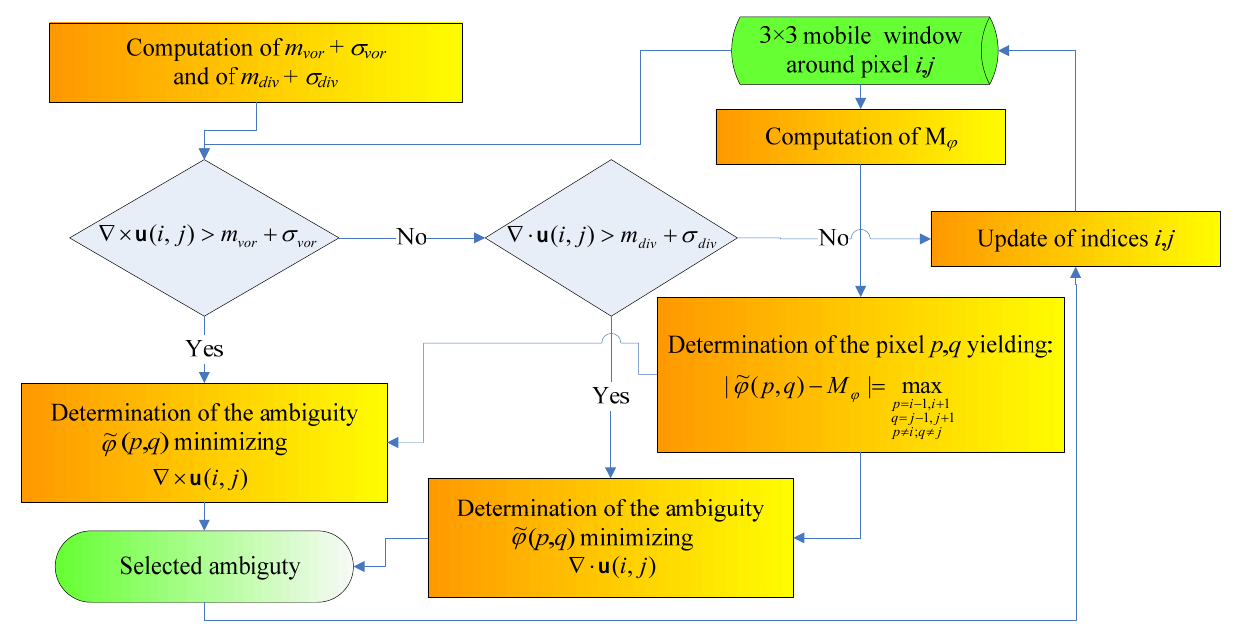
Figure 5 . Block diagram of the ambiguity selection procedure. Indices i , j denote the central pixel of the 3×3 mobile window; p may be equal to i- 1, or i +1; q may be equal to j- 1, or j